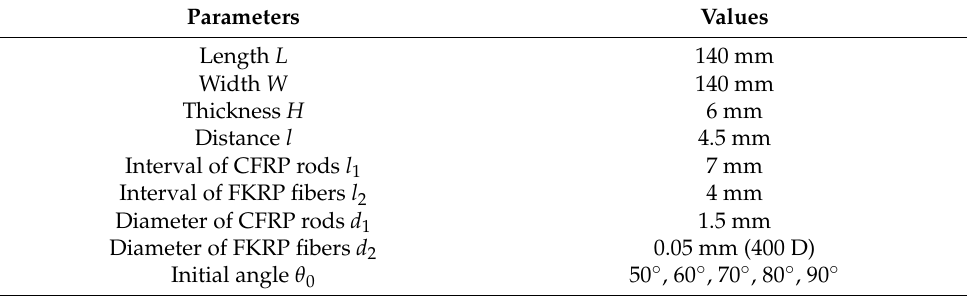
Table 1. Design parameters of the specimens.